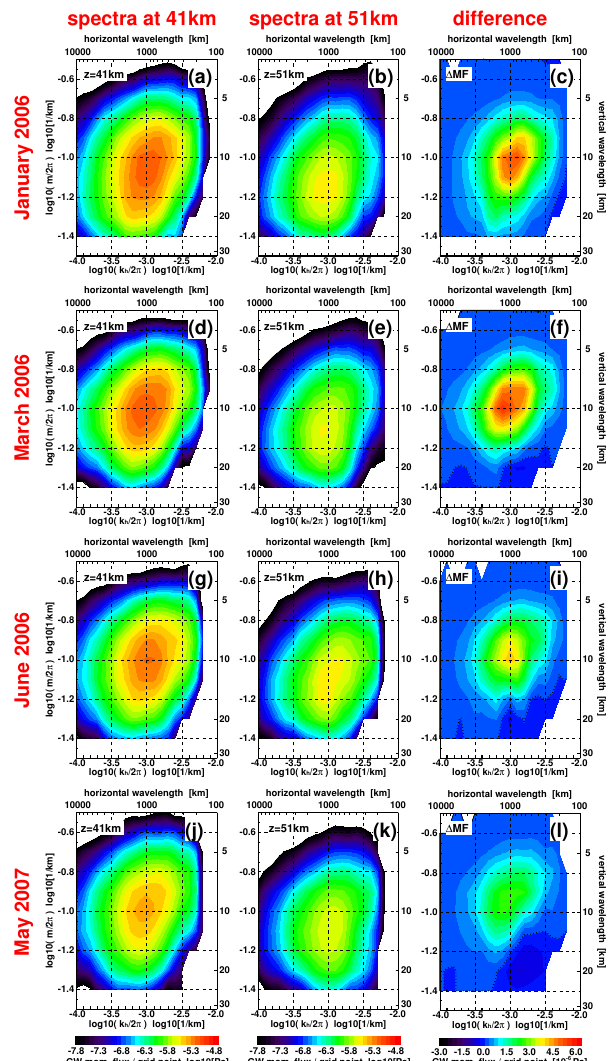
Figure 6. HIRDLS gravity wave momentum flux spectra for the four cases illustrated in Fig. 4. Upper row (a–c) : January 2006, westward vertical shear of the zonal wind, u(z 1 ) < 0 and u(z 2 ) < 0; second row (d–f) : March 2006, eastward wind shear, u(z 1 ) < 0 and u(z 2 ) > 0; third row (g–i) : June 2006, westward wind shear, u(z 1 ) > 0 and u(z 2 ) < 0; and lower row (j–l) : May 2007, eastward wind shear, u(z 1 ) > 0 and u(z 2 ) > 0. The left column (a, d, g, j) shows spectra for 41km altitude, and the middle column (b, e, h, k) for 51km altitude. These altitudes correspond to the lower and upper levels z 1 and z 2 , respectively, in Fig. 4. The right column (c, f, i, l) shows the differences between the spectra at 41km and the spectra at 51km